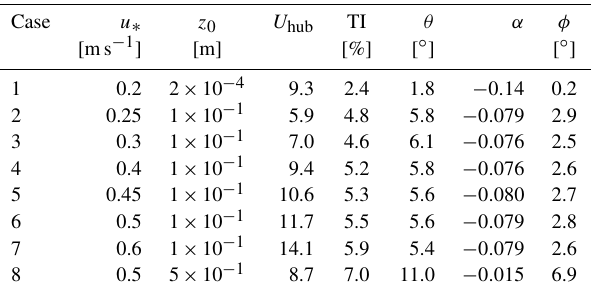
Table A1. Inflow characteristics for each case in complex terrain.